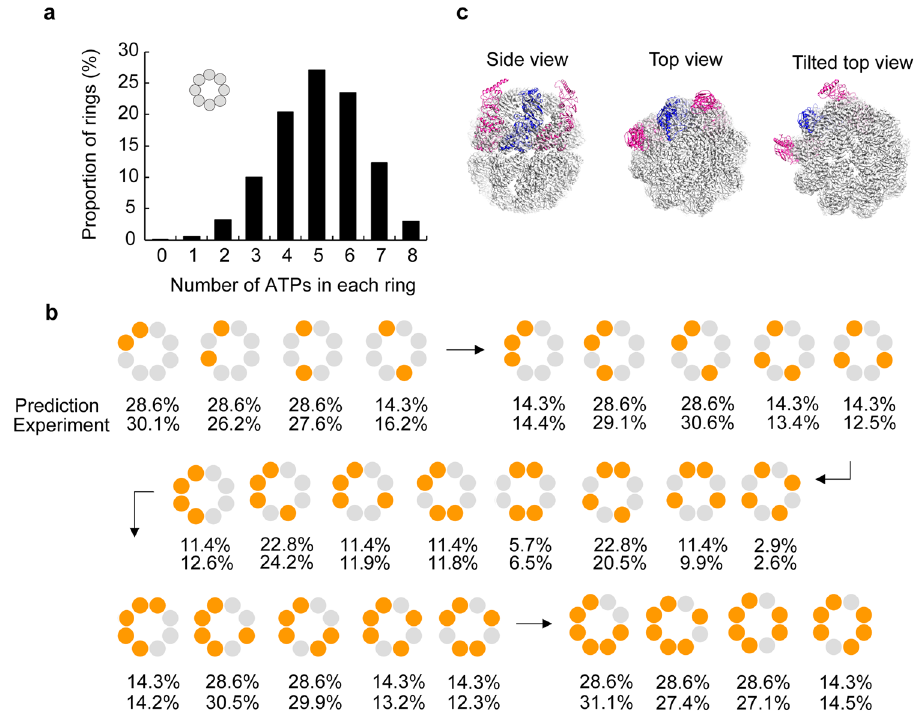
Fig. 4 Intra-ring ATP occupancy and distribution. a Nucleotide occupancy in the rings analyzed. b Probabilistic prediction and experimental observation of nucleotide distribution at different nucleotide occupancy levels (i.e., 2,3,4,5,6 nucleotides annotated as orange balls). c Model of the triple subunits superimposed on fully closed form (gray density) shows the middle subunit in the triplet in closed form while left and right subunits can exist in an open conformation.